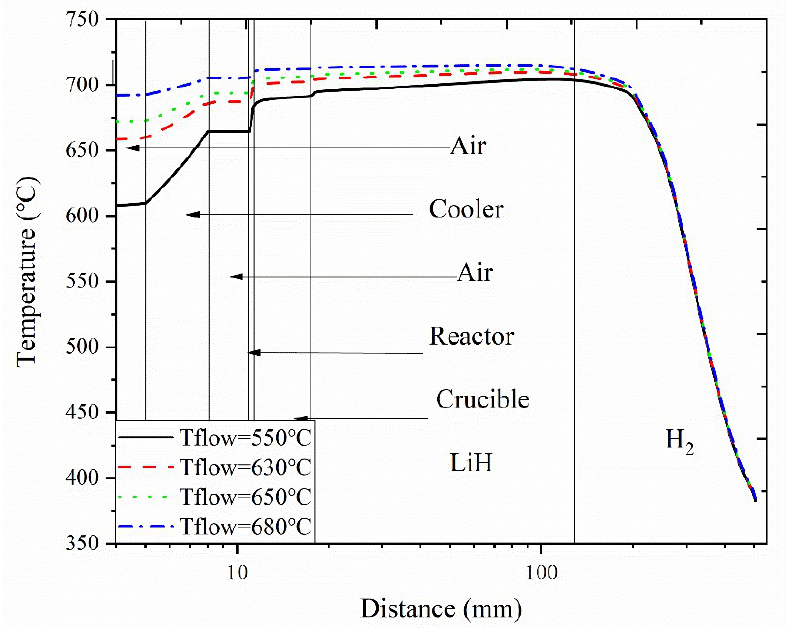
Figure 10. The temperature distribution in the central axis of the furnace.